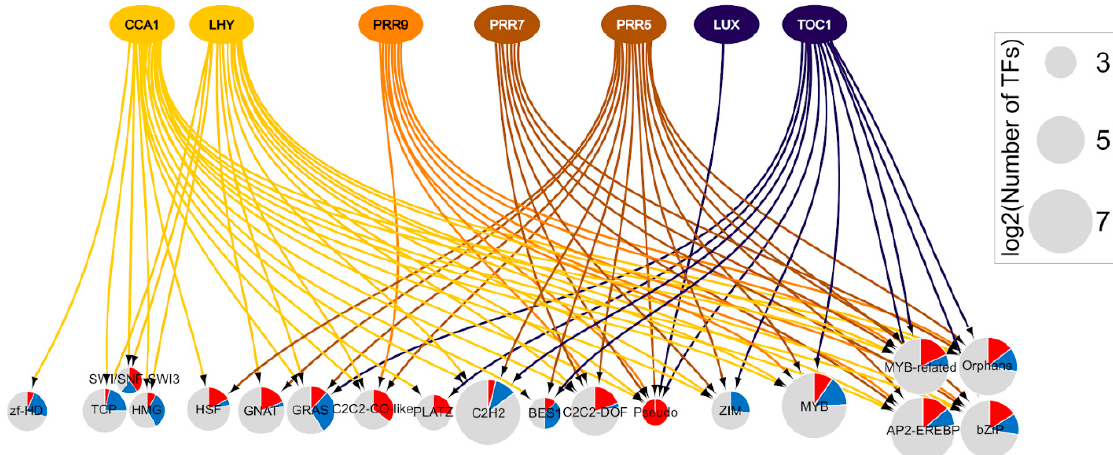
Figure 4. Transcriptional network of heat-responsive transcription factor families that are also cycling. The represented TF families are significantly over-represented in these high-temperature-responsive transcriptome datasets [43,50,59] (Supplementary Table S1), and include direct targets of CCA1, LHY, PRR7, PRR9, PRR5, LUX, and TOC1, based on ChIP-seq datasets [20,84–88,100,110]. The arrows in the network represent an interaction between the TF and its target. These connections indicate that at least one member of the TF family is a target of clock genes; however, not all members of the TF family are responding to heat. The node size for TF families reflects the size of the family, with the Log2-transformed total number of TFs. The colors in pie charts represent the proportion of TFs differentially expressed in response to heat. Blue pie: downregulated; red pie: upregulated; grey pie: not significant.